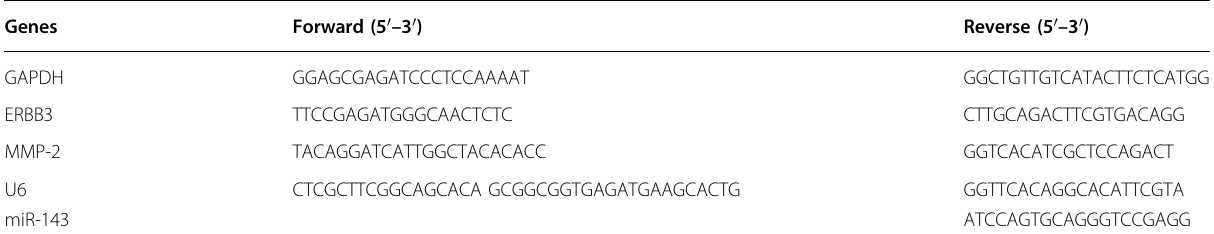
Table 1 Primers used for real-time